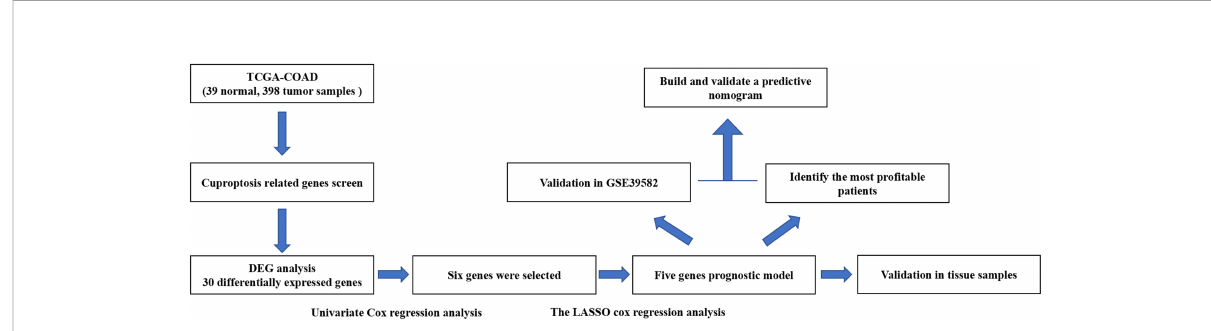
FIGURE 1 Flowchart illustrating the construction of curoptosis-related risk model in COAD